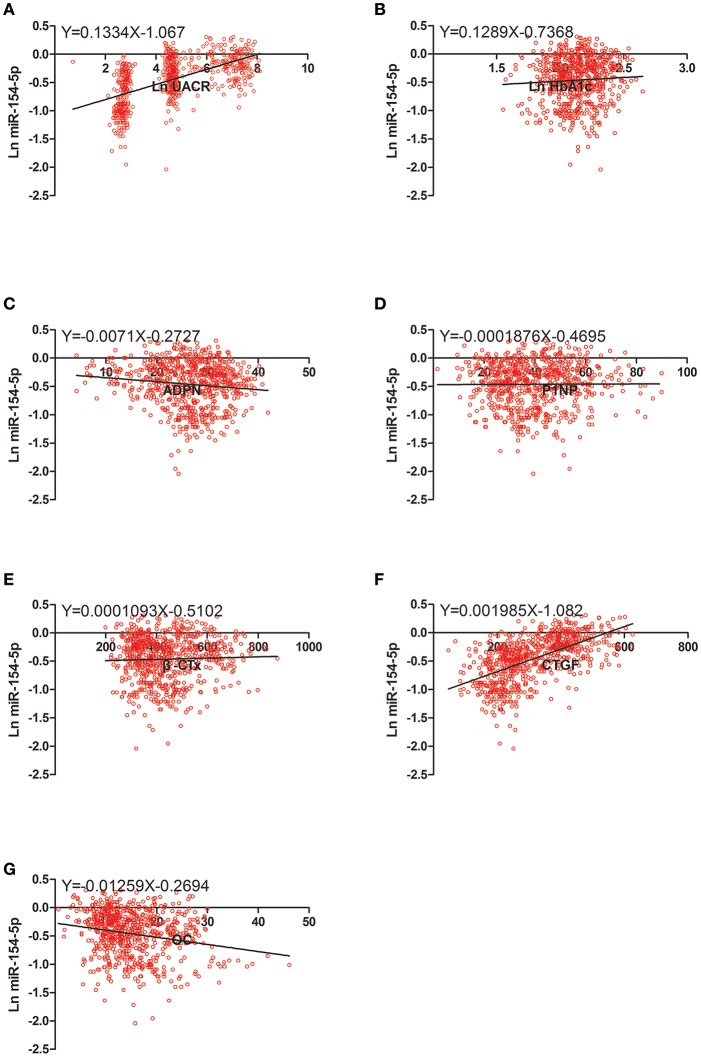
Scatter dot plots between Ln miR-154-5p and (A) Ln UACR, (B) Ln HbA1c, (C) ADPN, (D) P1NP, (E) β-CTx, (F) CTGF, (G) OC. UACR, urinary albumin excretion rate; HbA1c, glycated hemoglobin A1c; ADPN, adiponectin; P1NP, procollagen type 1 N-terminal propeptide; β-CTx, β-C-terminal telopeptide of type I collagen; CTGF, connective tissue growth factor; OC, osteocalcin.